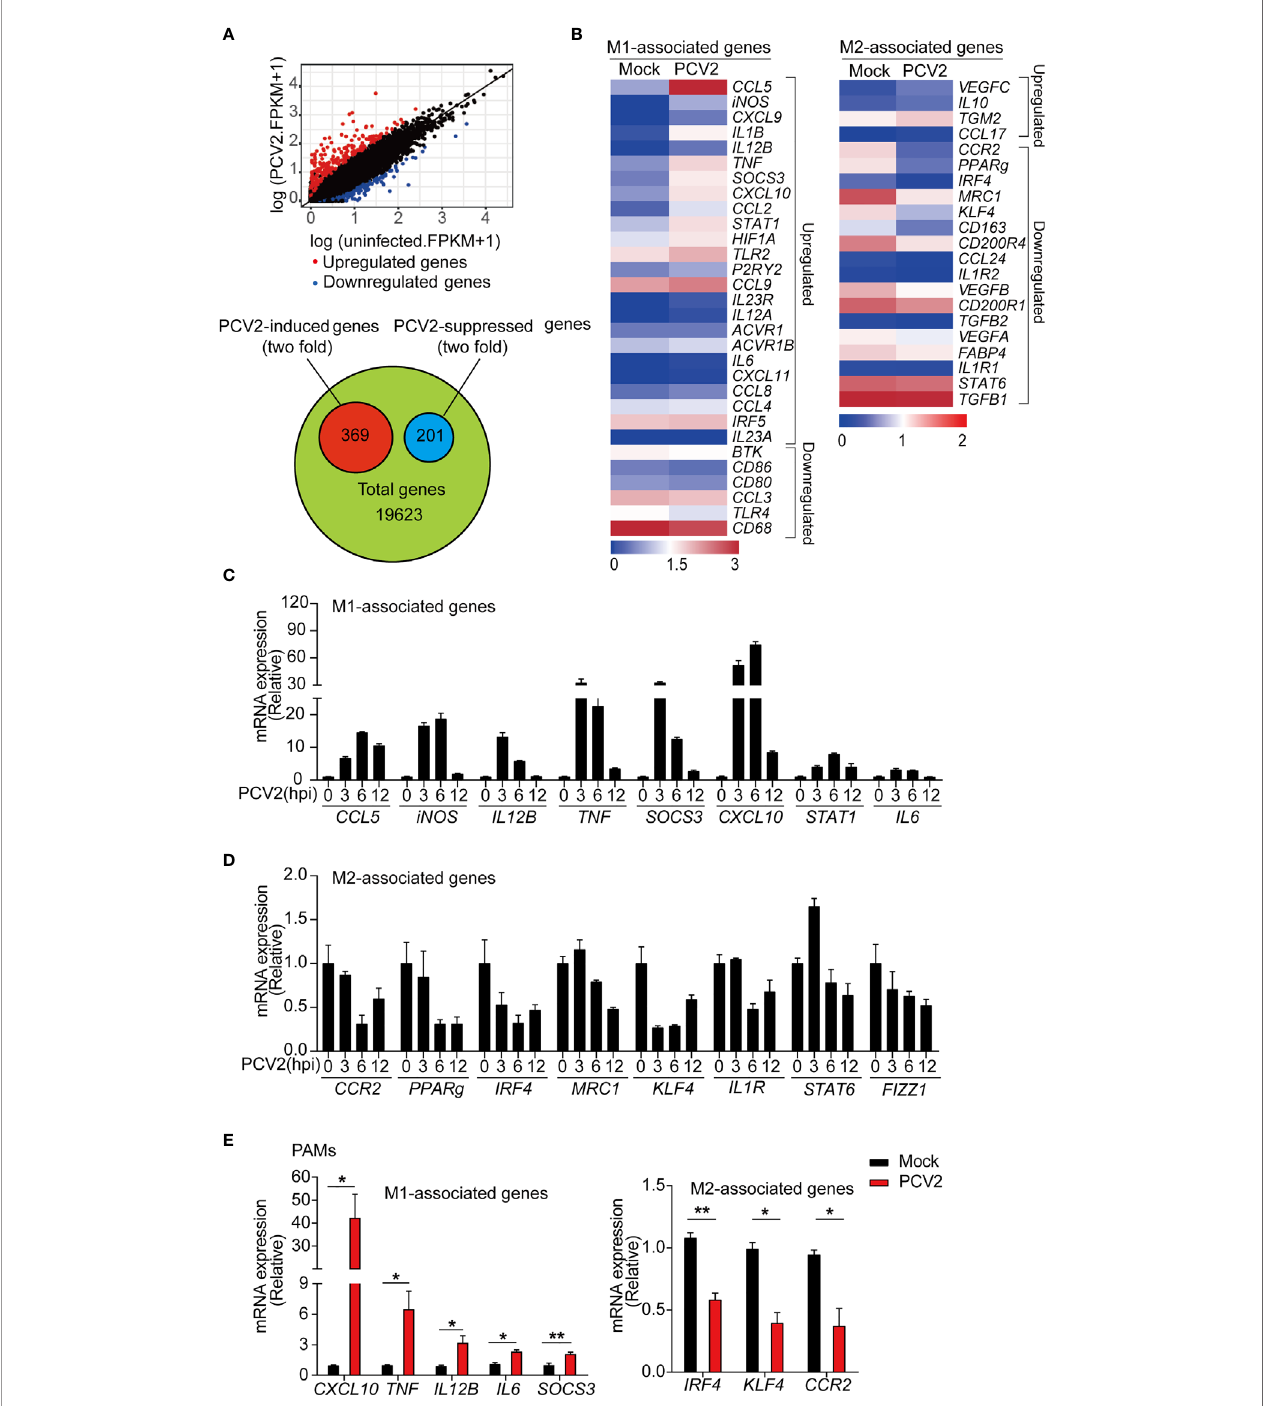
FIGURE 1 | PCV2 infection induces M1 macrophage polarization in vitro . (A) Scatter blot of RNA-seq analysis of differentially expressed genes in BMDMs left untreated or infected with PCV2 (MOI=0.02, the same dose below) for 12 h (top) and quanti fi cation of PCV2-induced genes or PCV2-suppressed genes in BMDMs (bottom). (B) Heatmap of M1-associated genes (left) and M2-associated genes (right) regulated by PCV2 infection in BMDMs. (C, D) Quantitative real-time PCR (qPCR) analysis of mRNA expression of representative M1-associated genes (C) or M2-associated genes (D) in BMDMs infected with PCV2 at indicated periods. (E) qPCR analysis of mRNA expression of M1-associated genes (left) and M2-associated genes (right) in PAMs infected with PCV2 for 24 h. Data are representative of one experiment (A, B) or three ( C, D ; mean + s.d. of technical triplicates) independent experiments or pooled from three ( E , mean + s.d.) independent experiments. * P < 0.05; ** P < 0.01 (Student ’ s t